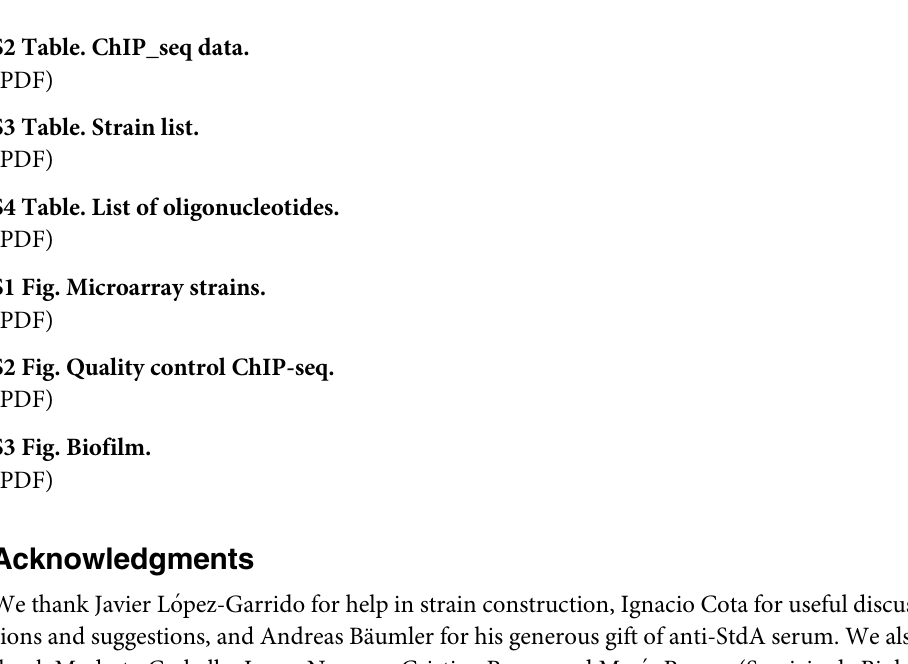
S4 Table. List of